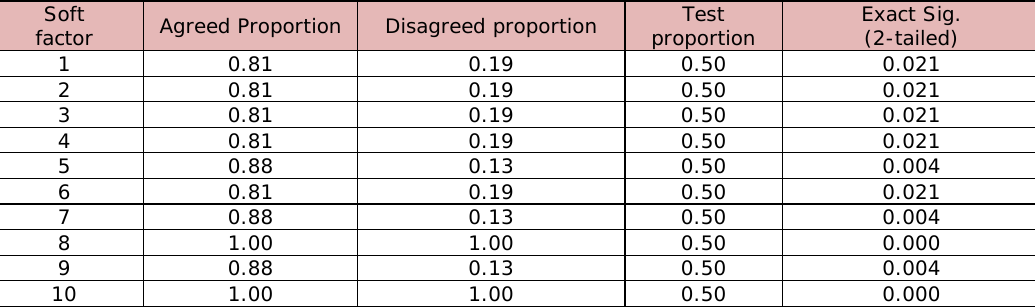
Table 1. "The results of the binomial